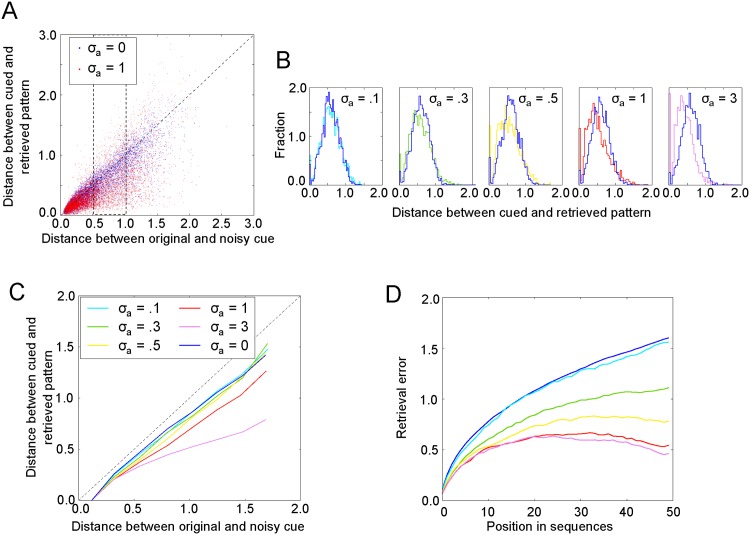
Pattern separation improves episodic memory retrieval.A: Example performance of single-pattern retrieval across different level of retrieval noise (raw data). B: Distribution of the distance between cued and retrieved patterns at different levels of pattern separation σa (only for the data within the dashed rectangle in A) as indicated by different colors. The legend is given in panel C, the reference σa = 0 is shown in dark blue. C: Average performance of single-pattern retrieval as a function of retrieval noise. D: Retrieval error for retrieval of sequences at different levels of σa (100 stored sequences, σn = 0.1, a: 2-D).